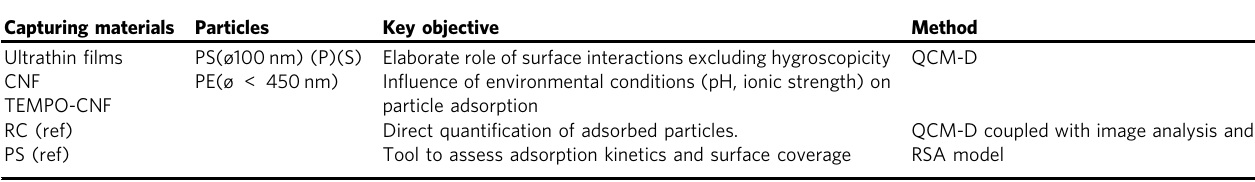
Main fi ndings: Entrapment of particles from aqueous dispersion is mainly governed by the high hygroscopicity of the nanocellulose network allowing the particles to be transported inside the structure. Attractive surface interactions play a role only when the strong repulsive forces are not dominating and the capillary forces are not assisting the capturing process.